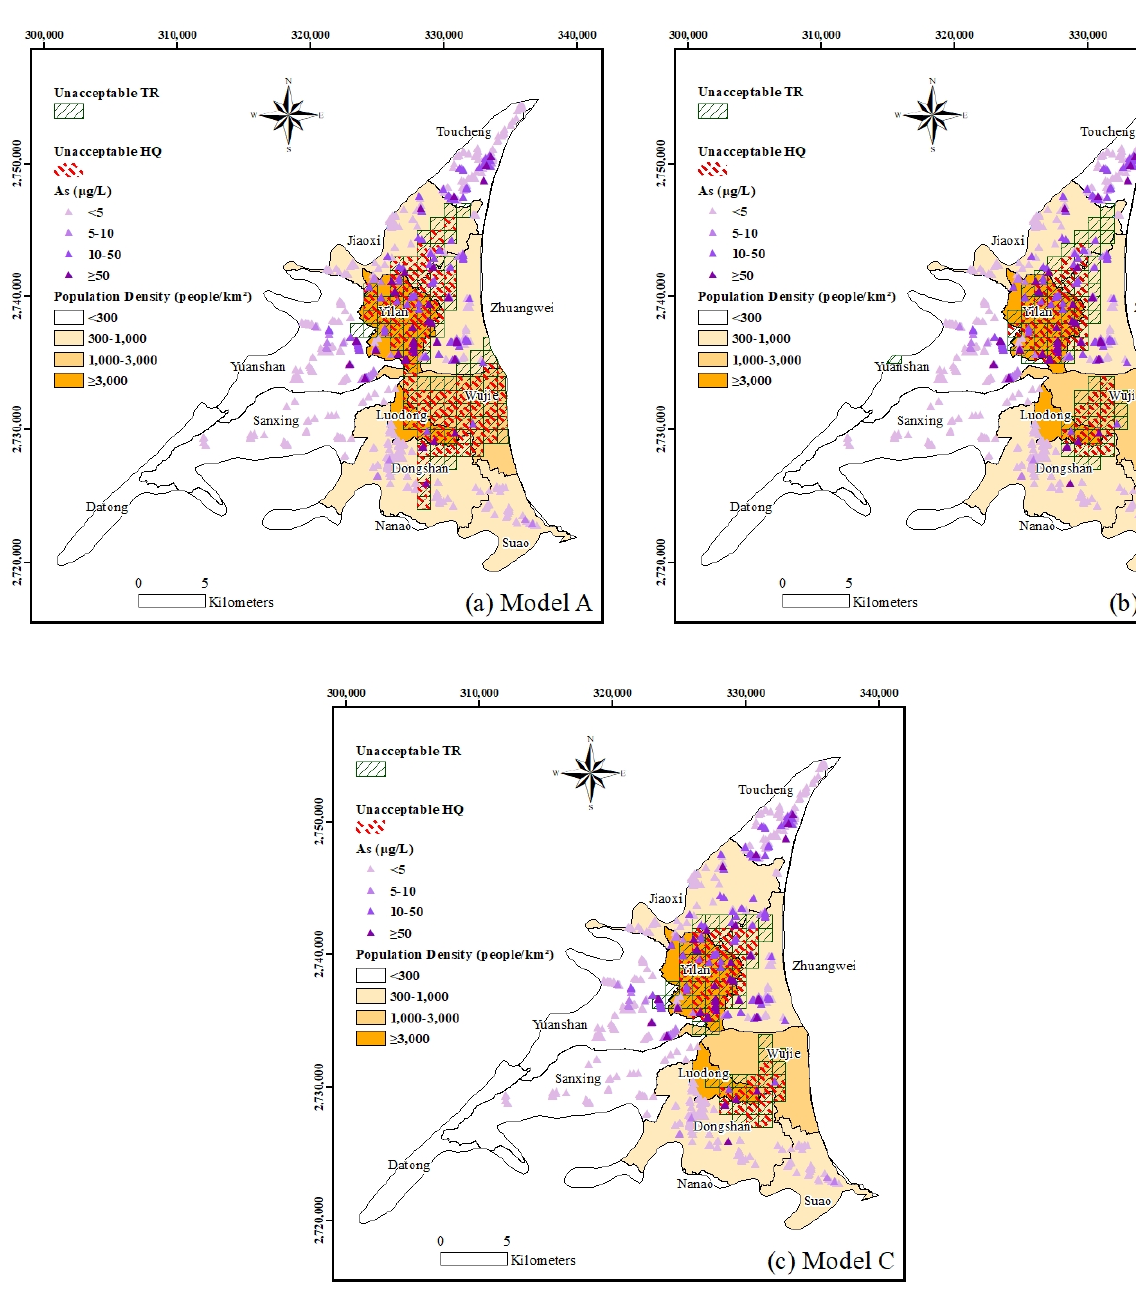
Figure 6. Spatial mapping of unacceptable HQs and TRs coupled with population density.